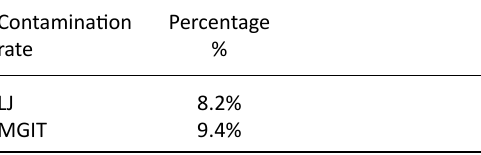
table 8. MGIT culture positivity confirmation